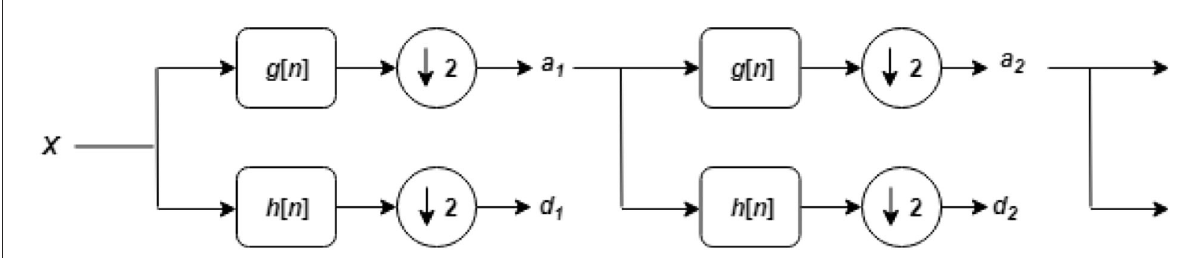
FIGURE2 Two levels of Discrete Wavelet Transform. g [ n ] and h [ n ] denote low and high pass filters, respectively. Number 2 indicates that the output of each filter is decimated by a factor of two. a i denote approximation coefficients and d i detail